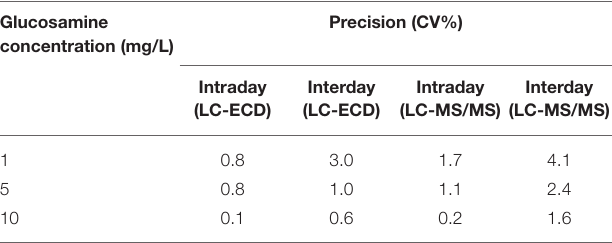
TABLE 3 | Intra- and interday precisions (expressed as coefficient of variation, CV%) for quantifying glucosamine reference solution measured by LC-ECD and